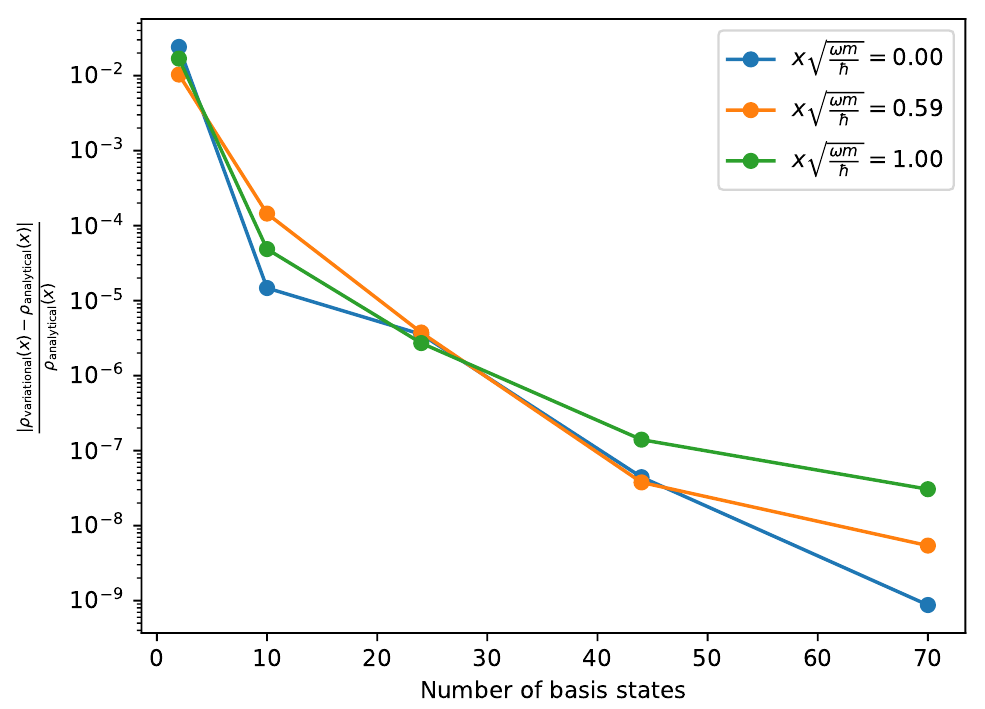
Figure 5: Detailed comparison between position space density in the 1 + 1 system at (cid:113) m = 1 at particular values of x compared to the analytical g ħ h 3 ω